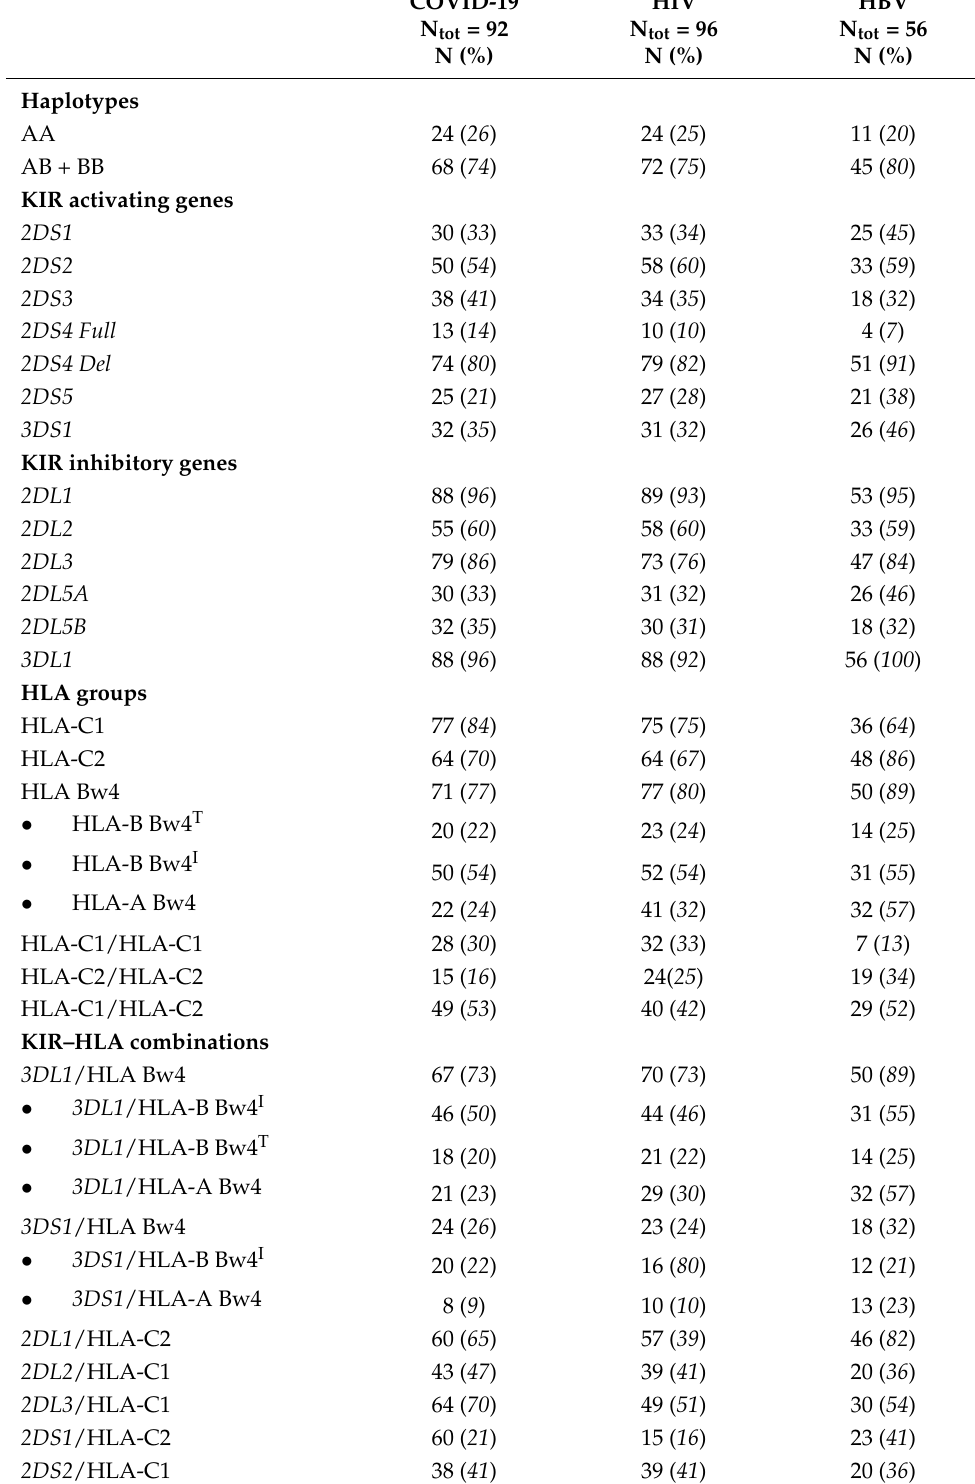
Table 1. KIR and HLA gene and haplotype frequencies (%) in different groups of infected